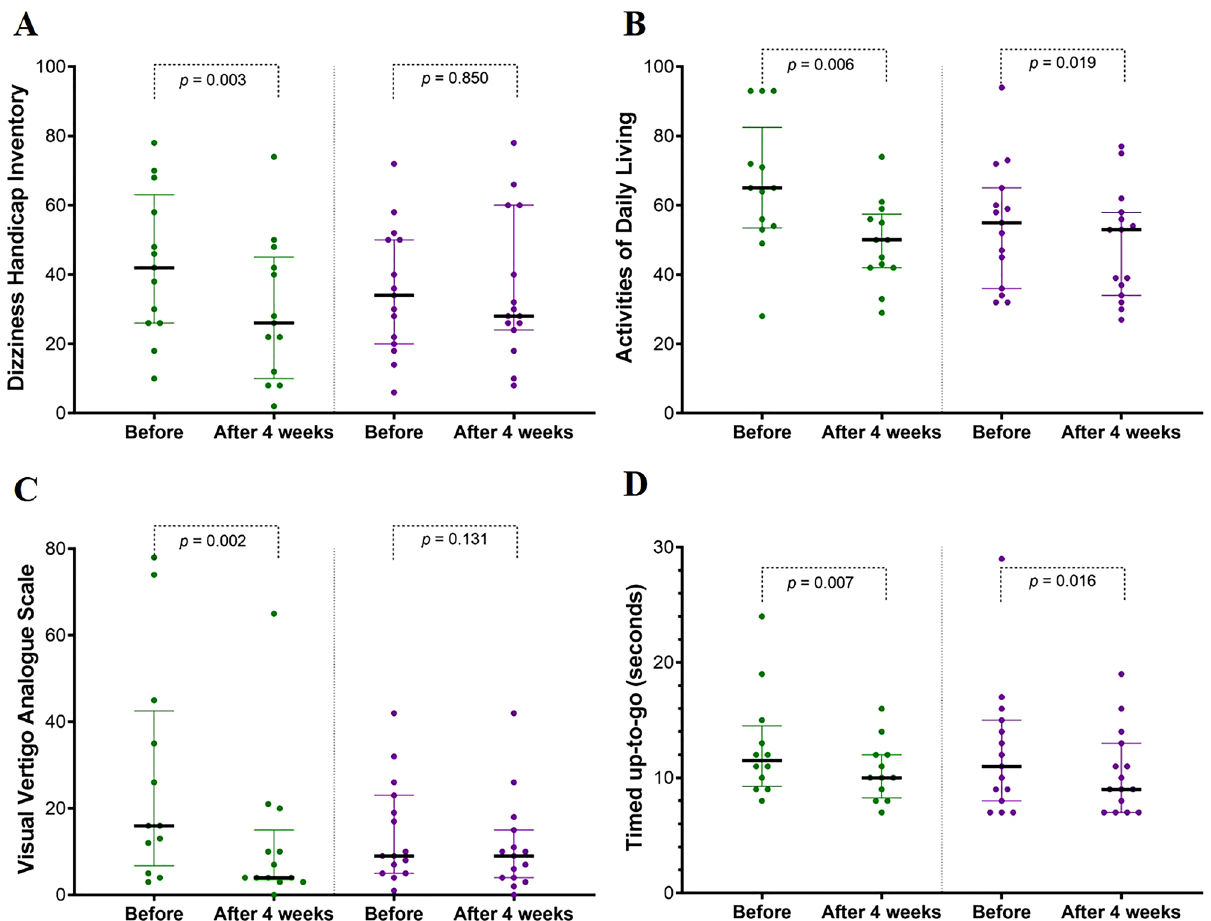
Figure 2. Dizziness handicap inventory (DHI, A ), vestibular activities of daily living (ADL, B ), visual vertigo analogue scale (VVAS, C ), and time of timed up-to-go test (TUG, D ) before and after treatment. All questionnaires and TUG time scores were significantly improved in the vestibular exercise (VE) group (green); however, only ADL and TUG time were improved in the VE with optokinetic stimulation (OS) group (purple). Every dot is each score or time of patient. The green or purple bars indicate the interquartile range, and the horizontal black bars identify the median value of each group. All p values were assessed with the Wilcoxon signed rank